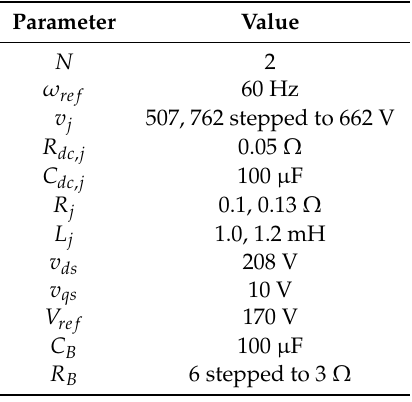
Table 3. Typhoon HIL 602